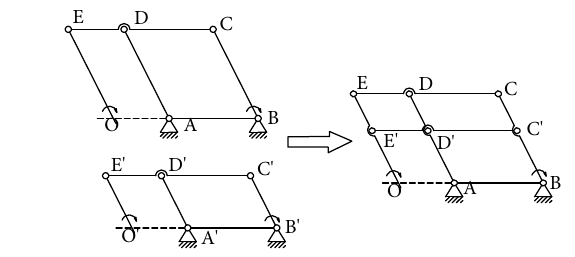
Figure 7: Combination of VRC modular